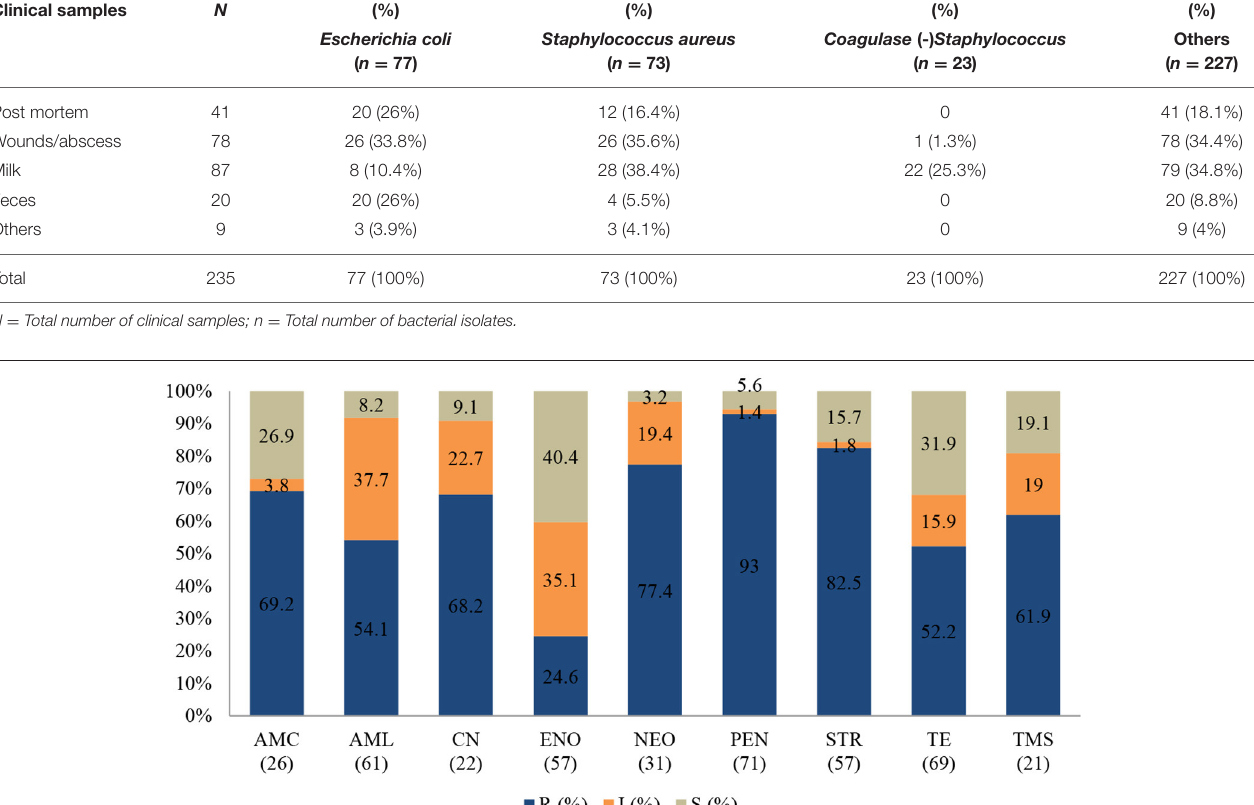
TABLE 1 | Species of bacteria isolated from samples of diseased ruminants received by the Bacteriology Laboratory between 2015 and 2017. Clinical samples